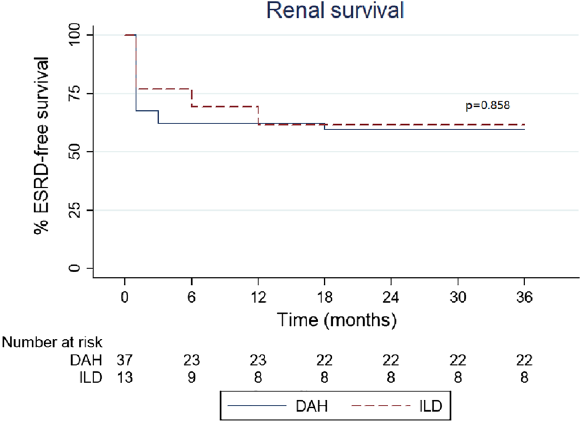
Figure 3. Comparison of renal survival between the DAH and ILD groups in the 3-year